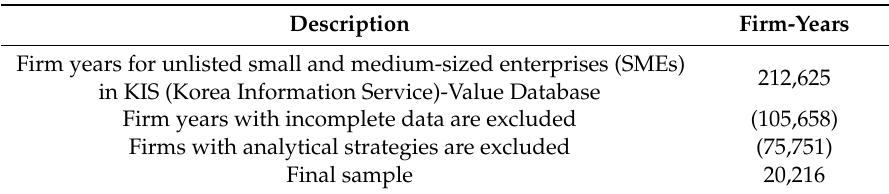
Table 2. Sample selection.